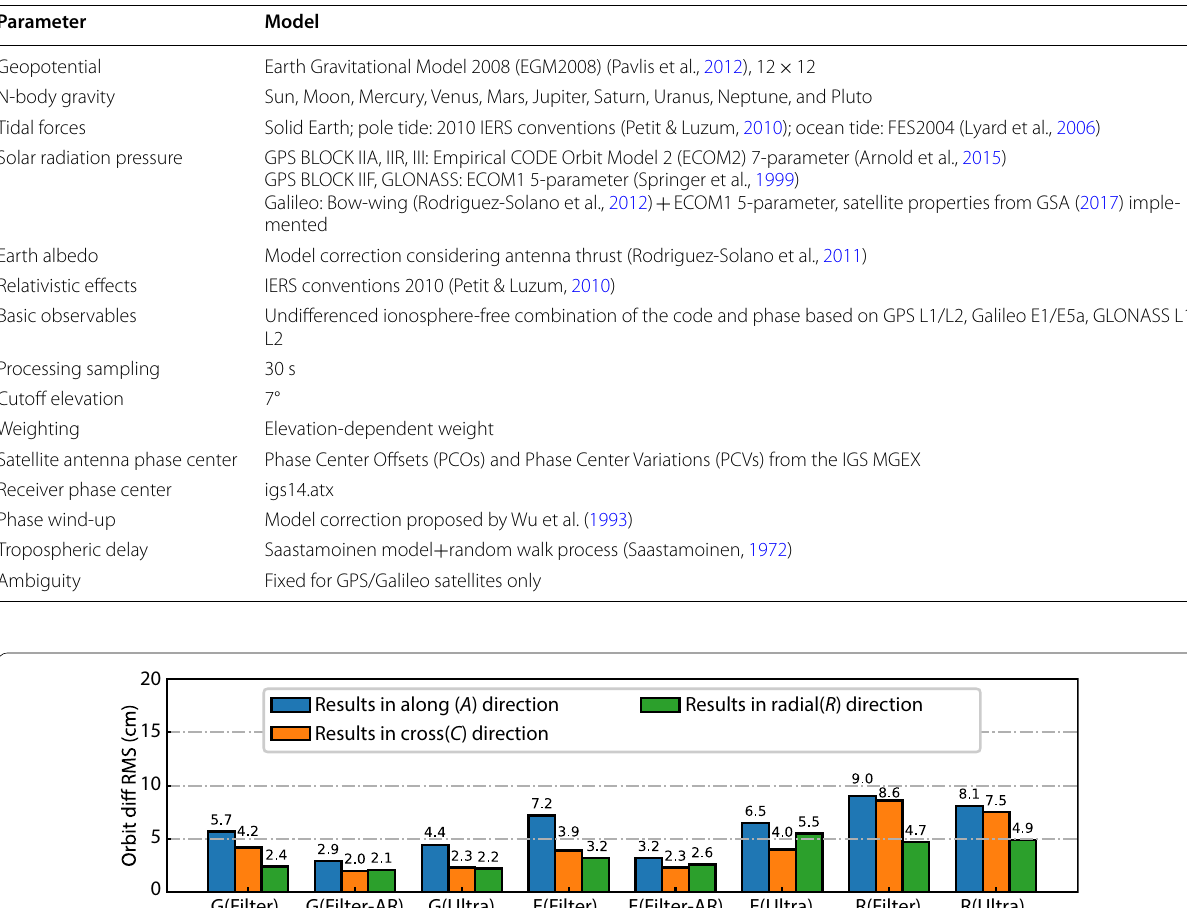
Table 3 Real-time filtering orbit determination dynamics and observation models Parameter Model